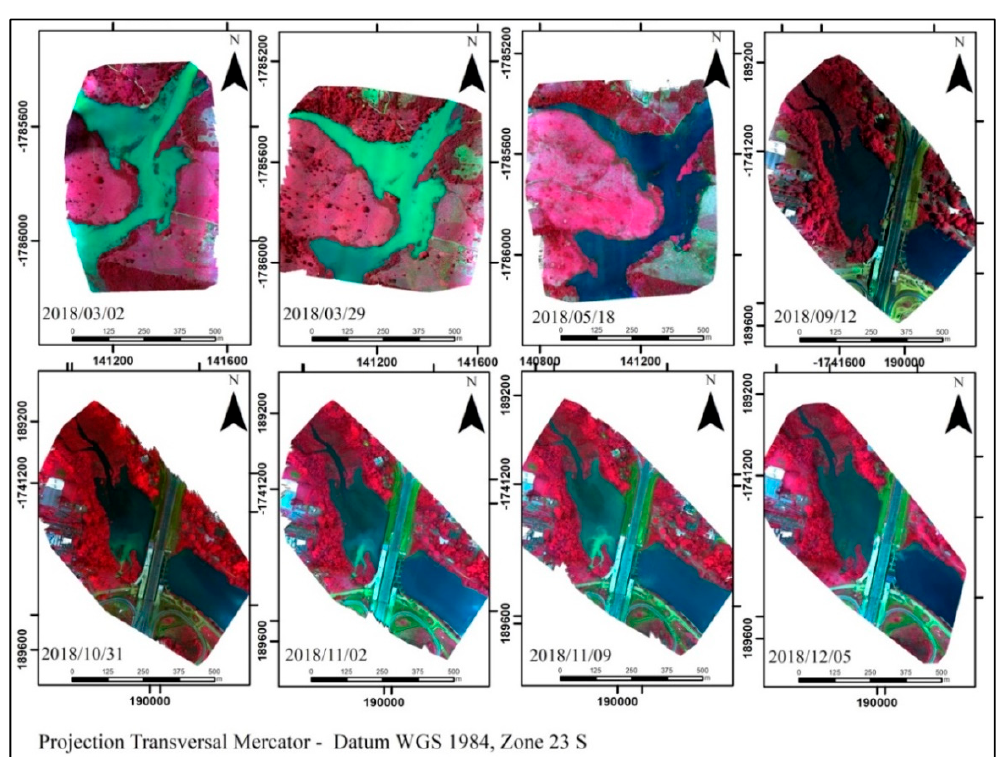
Figure 8. NIR / red / green color composite band for all surveyed dates in Parano á and Corumb á IV . Figure 8. NIR/red/green color composite band for all surveyed dates in Paranoá and Corumbá IV . Remote Sens. 2020 , 12 , x FOR PEER REVIEW 11 of 22